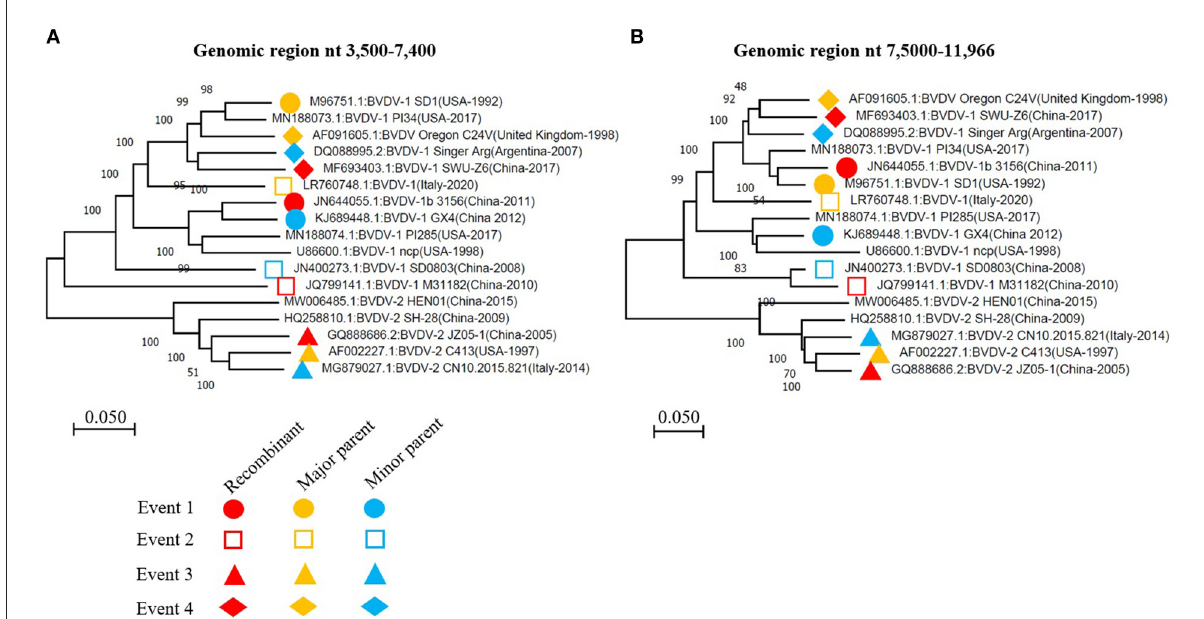
FIGURE4 The phylogenetic analysis based on the indicated fragments of BVDV genomes that have been involved in recombination events. (A) Phylogenetic tree based on the region nt 3,500-7,400 of BVDV genome. (B) Phylogenetic tree based on the region nt 75,000-11,966 of BVDV genome. The viruses involved in recombination events 1, 2, 3, and 4 were labeled with different symbols in the phylogenetic trees constructed using the neighbor-joining method. The recombinant, major parent and minor parent were indicated with red, orange and blue color, respectively. The nucleotide sequence is relative to BVDV-1 (GenBank: JQ799141.1, China-2010).